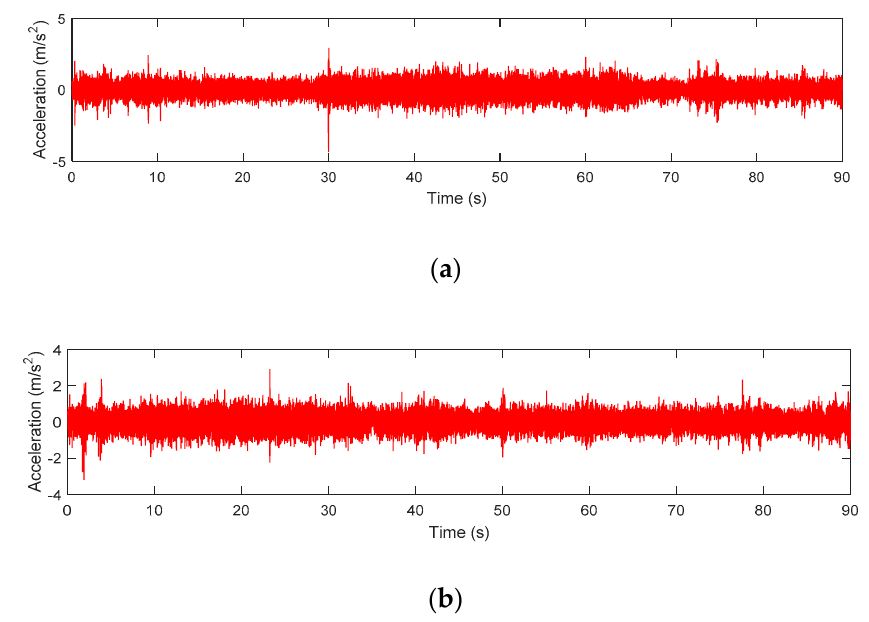
Figure 6. Collected top mount acceleration time histories: ( a ) Highway A, ( b ) Highway B.